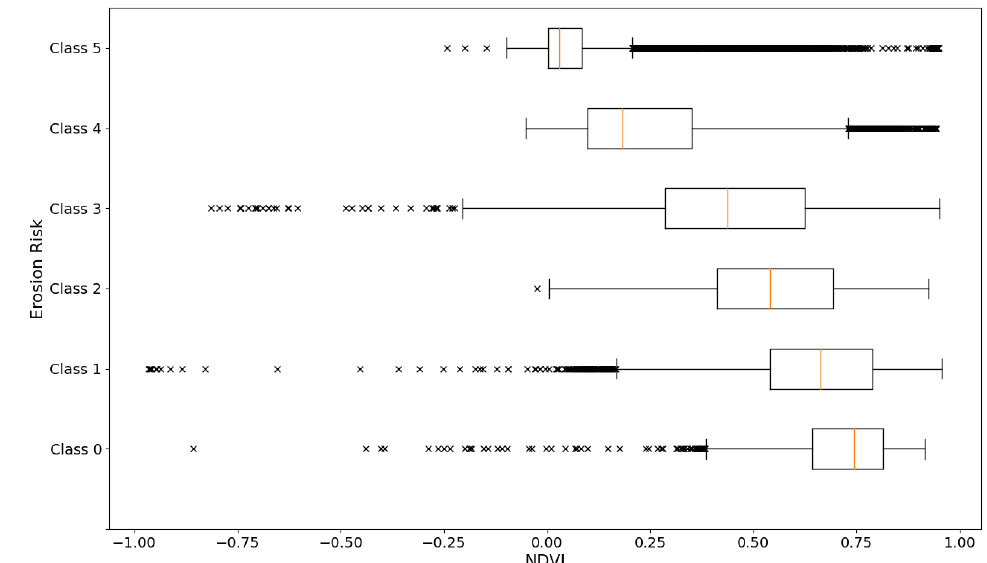
Figure 7. The distribution of NDVI values across all regions in the training dataset, separated by soil erosion risk